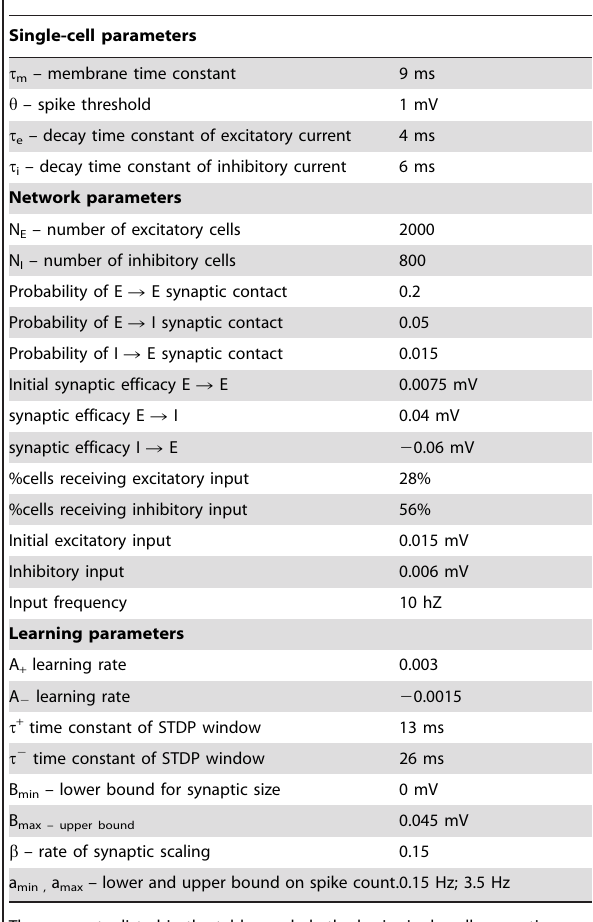
Table 2. Values for simulation